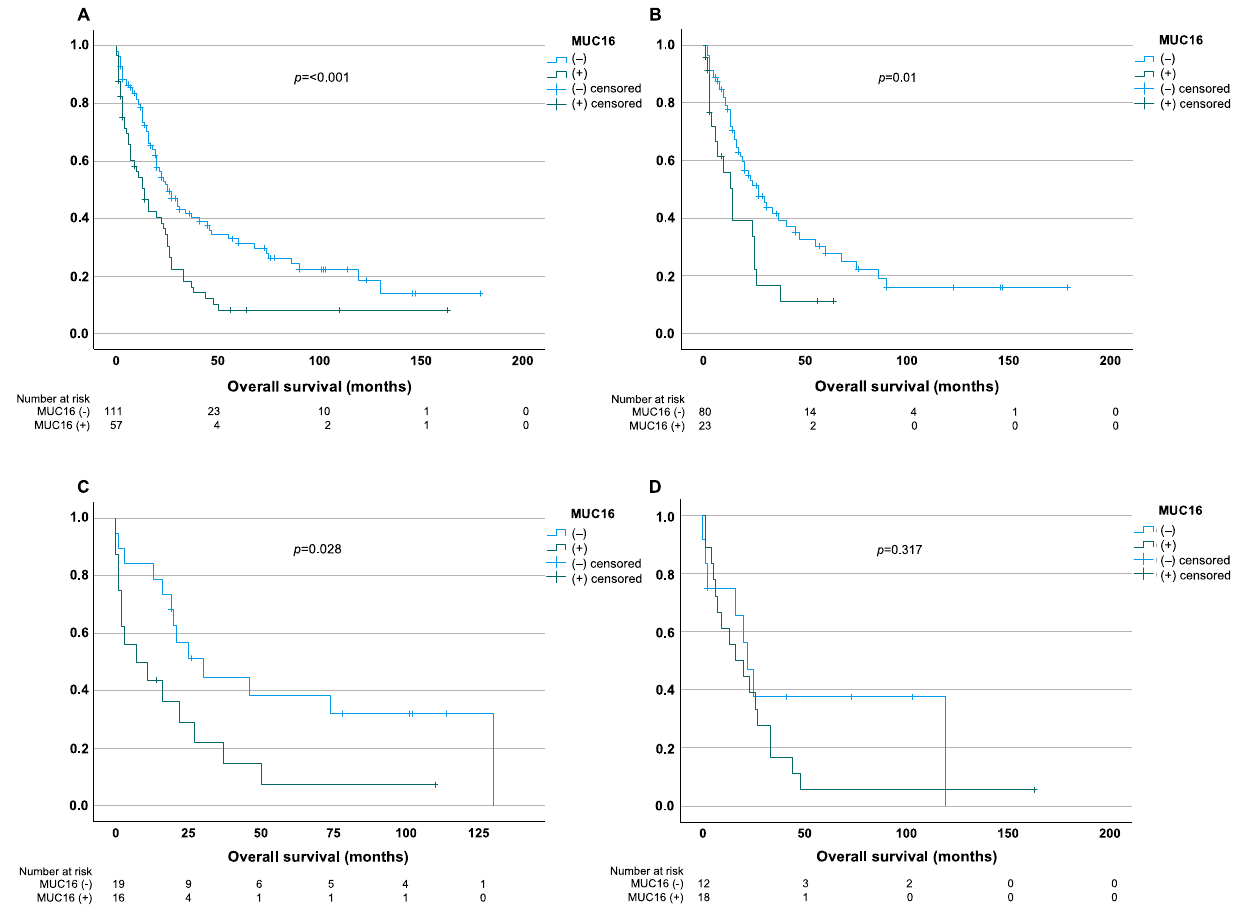
Figure 3. Kaplan–Meier curves for the overall survival in MUC16 ( − )/(+) patients with CCA. ( A – D ) The overall survival that was assessed for immunohistochemical expression of MUC16 for